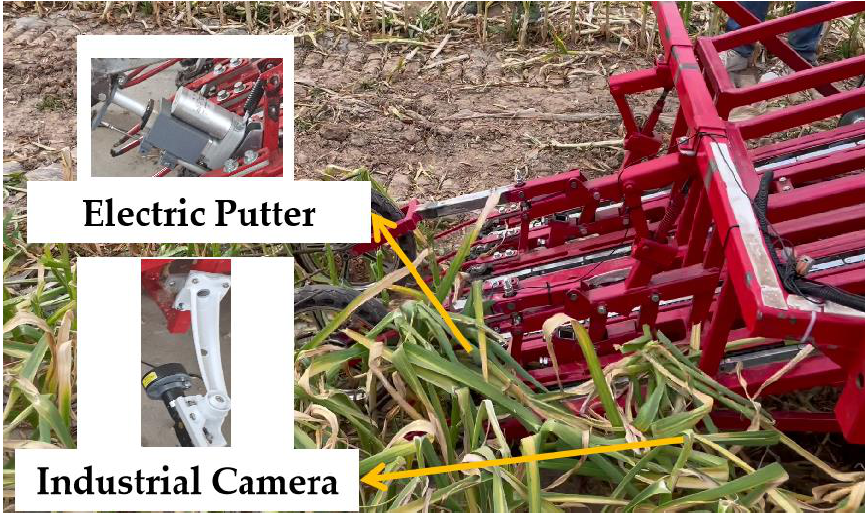
Figure 18. Field conditions.